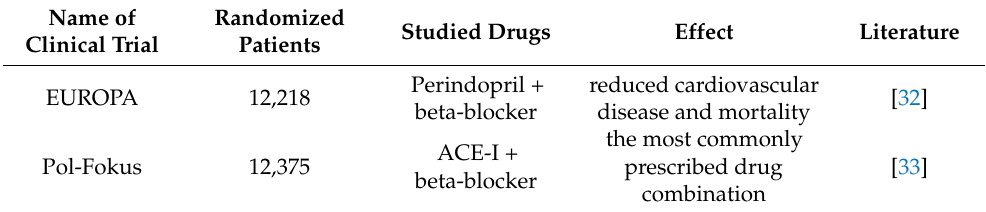
Table 3. Clinical